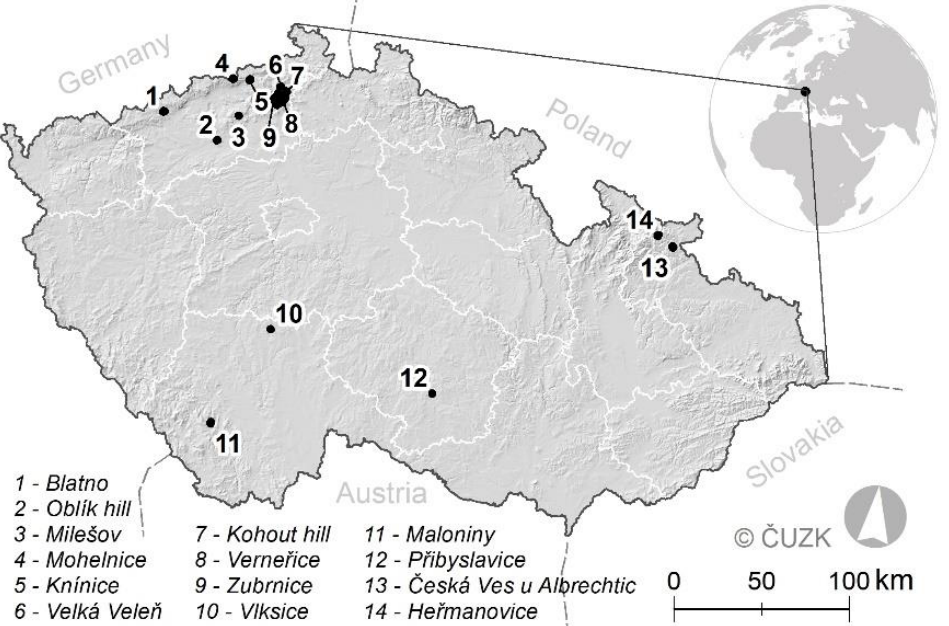
Figure 1. Location of study sites within Czechia and Europe (the KML file with detailed study sites can be found in Supplementary Material SA) [data sources: ArcČR® 500, ©ArcČR, ARCDATA PRAHA, ZÚ, ČSÚ, 2016, Czech Republic, ZABAGED® — Altimetry —DMR 5G, ČÚZK, Praha, Czech Republic; processed in ArcGIS, ESRI, Redlands, CA, USA].